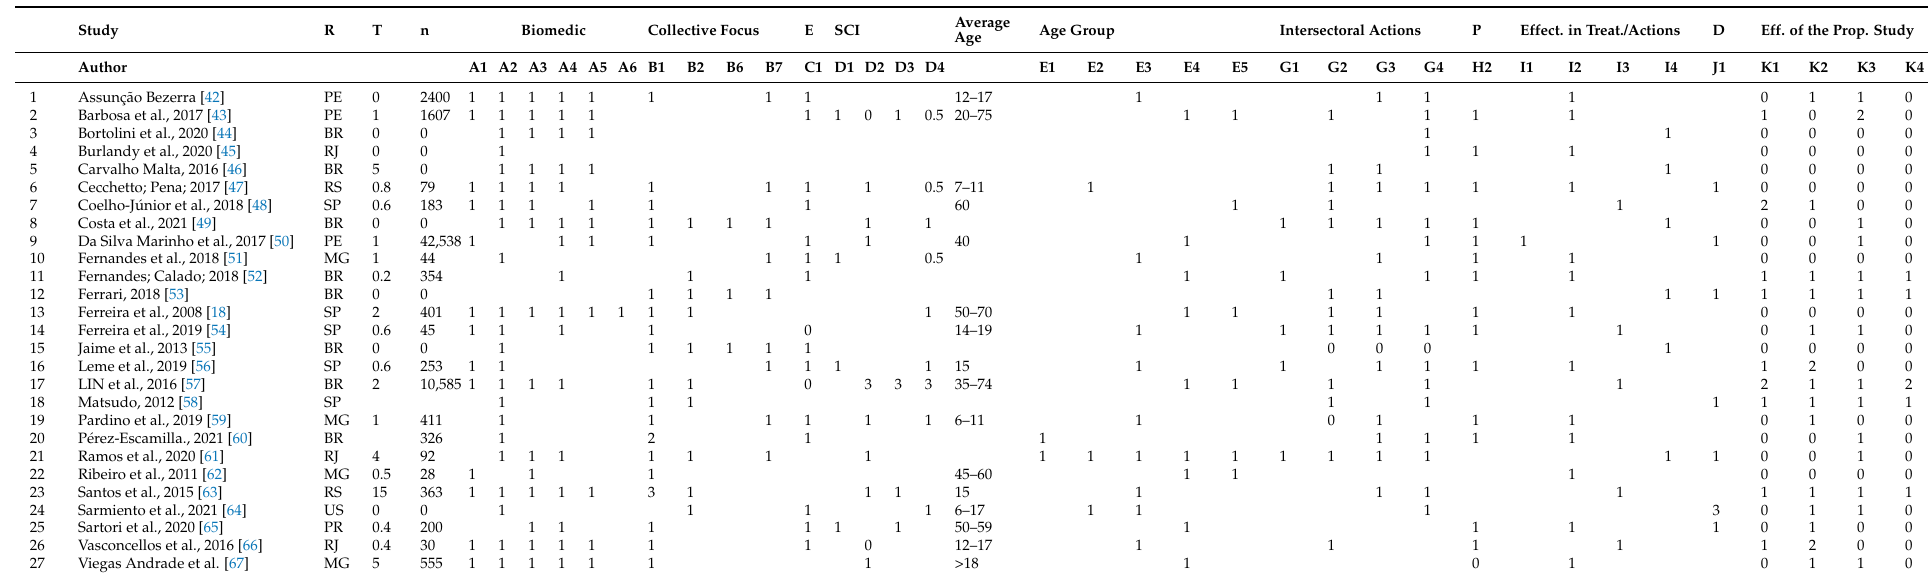
Table 1. Characteristics of the